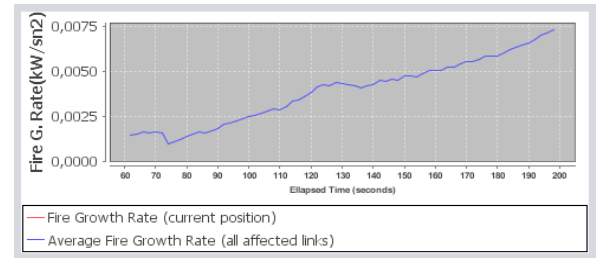
Figure 11. Temperature-time chart.